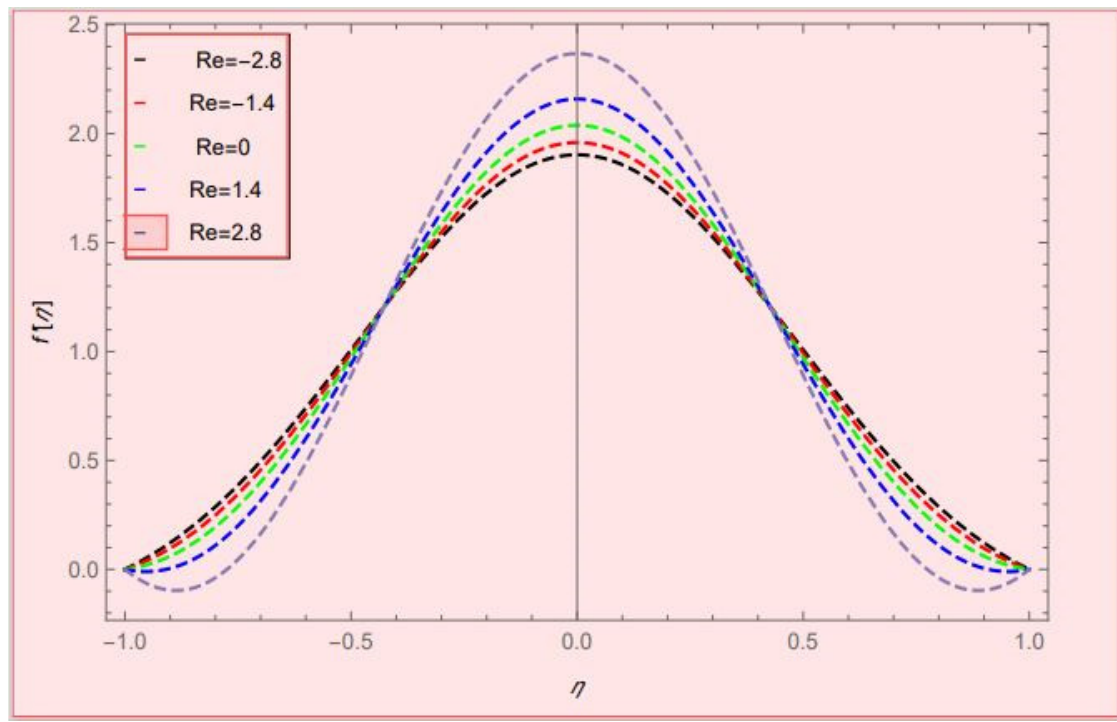
Figure 7. Velocity profile effect against the Reynolds number for 𝛼 = 3.2,𝑃𝑟 = 0.1, 𝑁𝑡 = 𝑁𝑏 = 0.5, 𝑀 = 8, 𝛽 = 1.4, 𝐵𝑟 = 0.1, 𝜑 (cid:2869) = 𝜑 (cid:2870) = 0.02, ℎ = 2, 𝑟 = 1.5.